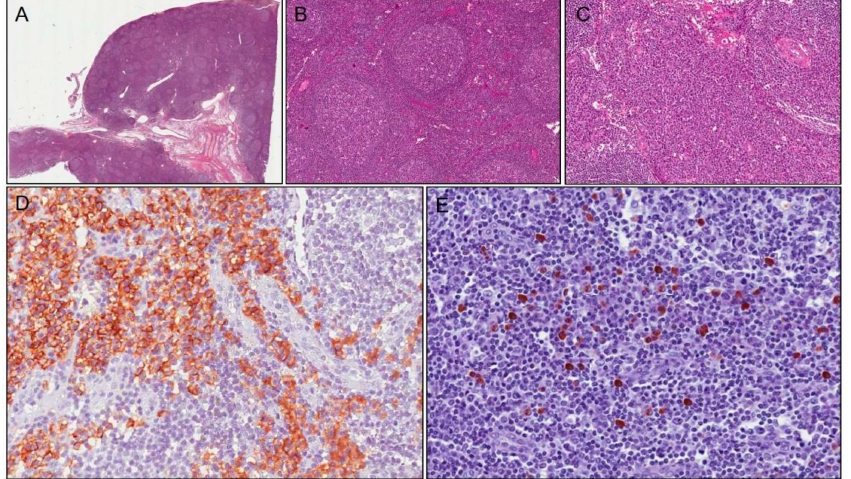
Figure 1. Case 1: histological examination shows follicular hyperplasia ( A ); with thickened mantle zones and lymphocytes arranged in layers—an onion skin appearance ( B ); there are numerous plasma cells in interfollicular area ( C ) stained with CD138 ( D ). Immunoreactivity for IgG4 shows positivity in about 40 plasma cells/HPF ( E